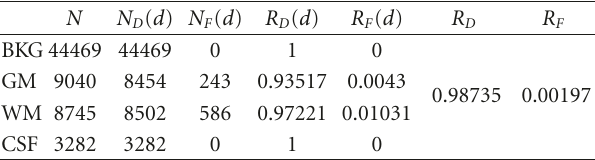
Table 3: Assessment results of perceptron network